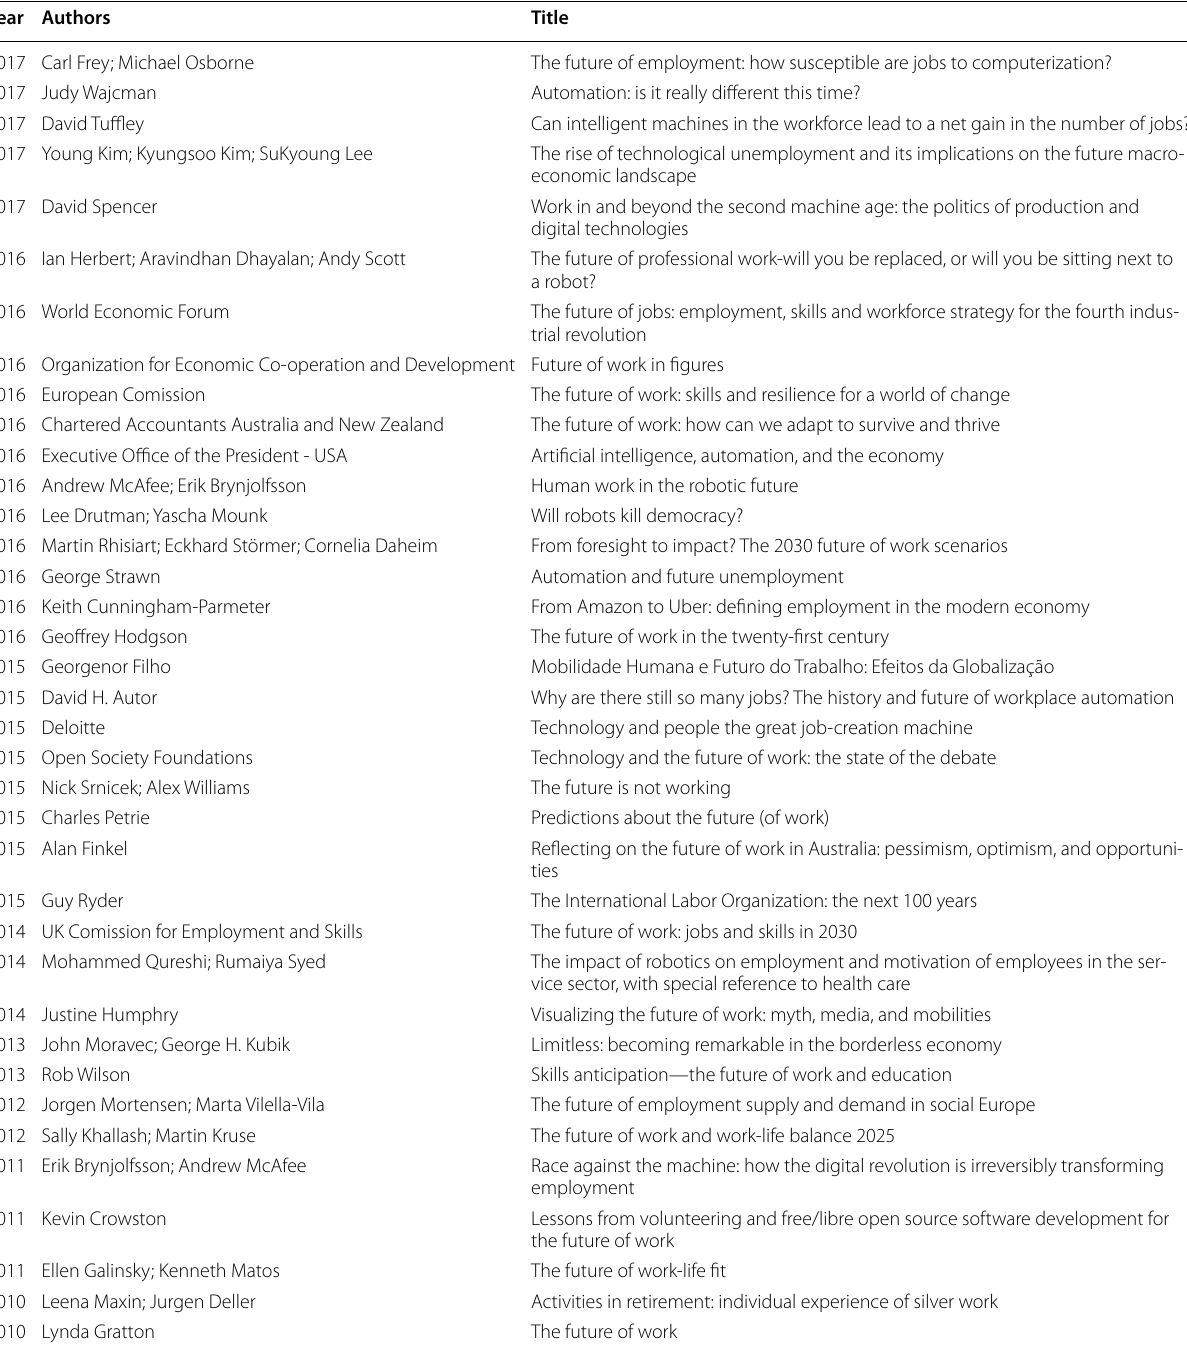
Table 2 Results for the bibliometrics method for the employment